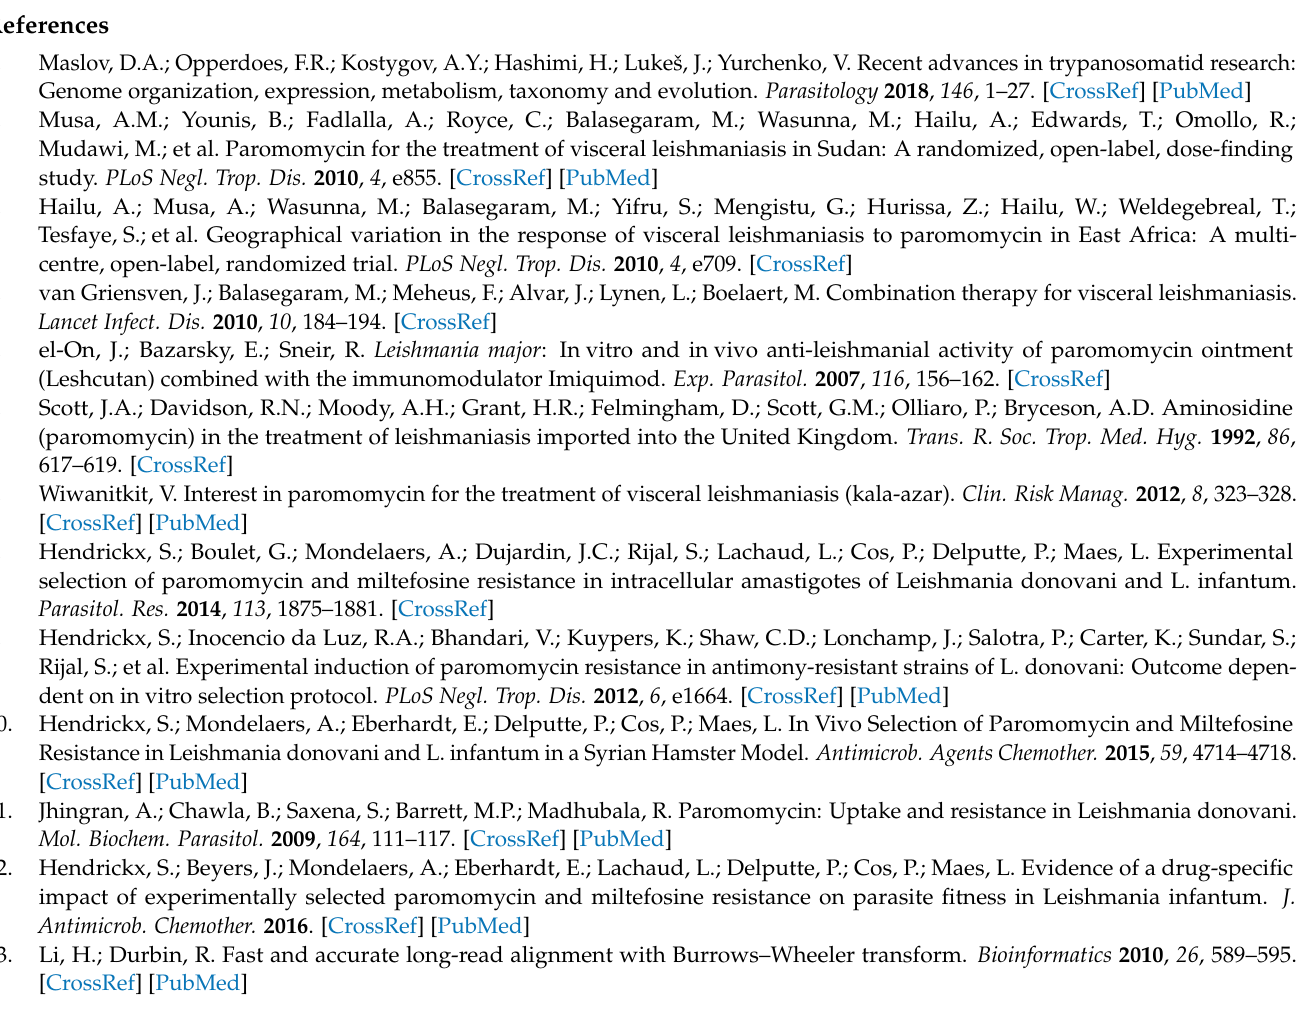
Table S1: WGS read libraries and SNV counts in the 12 clones and the polyclonal original population (Pre S57), Table S2: SNV correlated to PMM